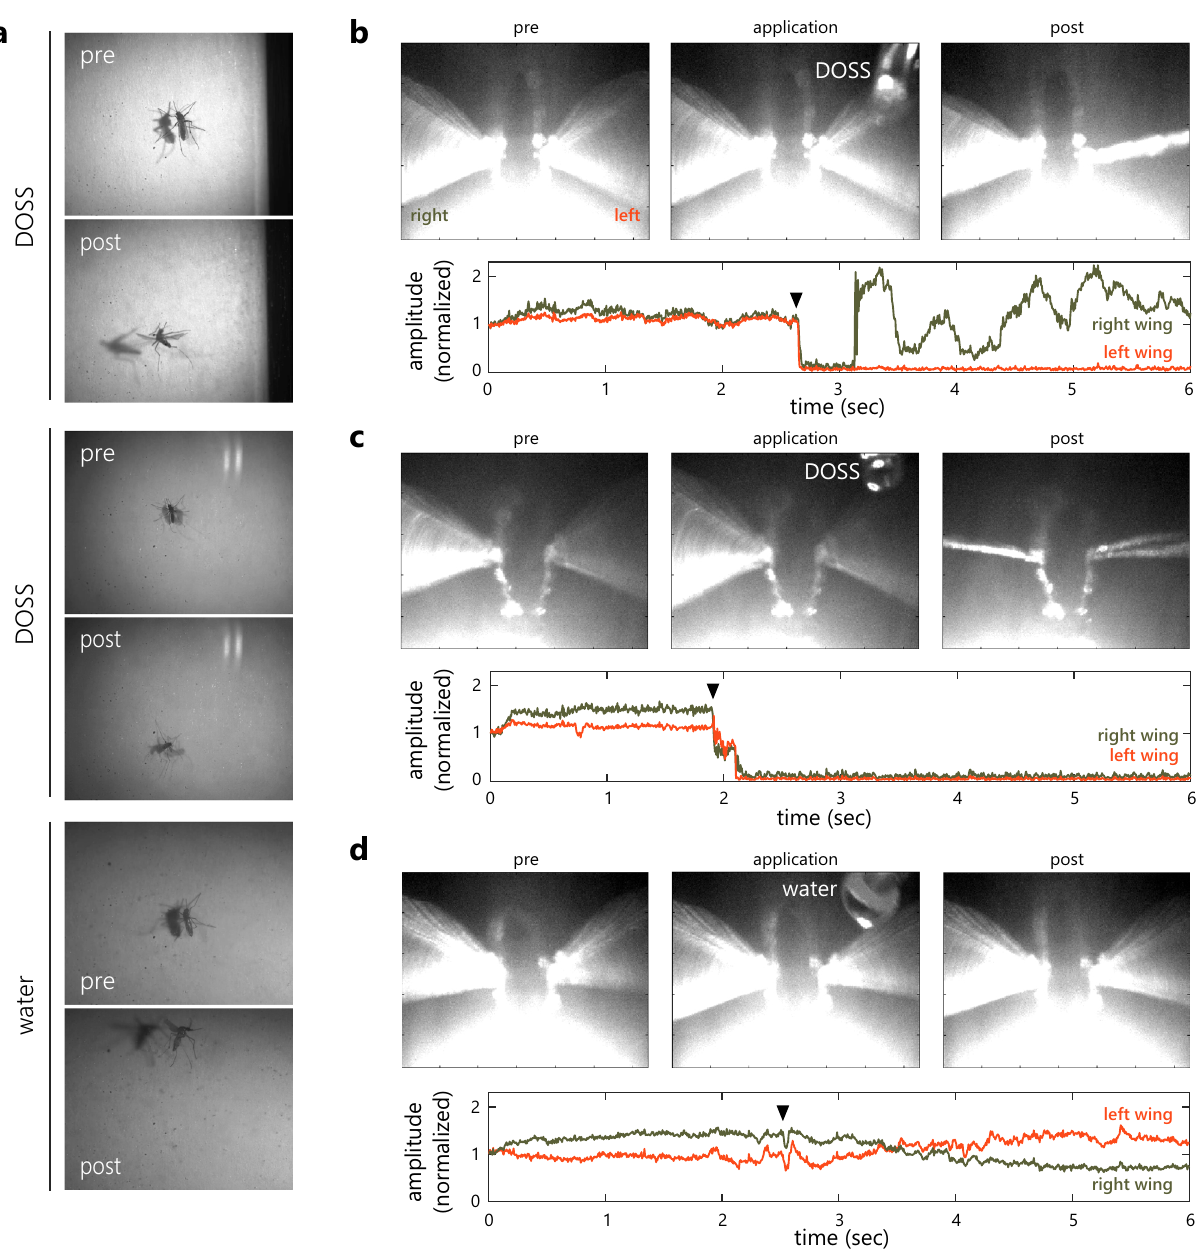
Figure 2. Surfactants affect mosquito flight. ( a ) Snapshots of movies taken with a high-speed camera capturing the behavior of mosquitoes on the wall after being sprayed with DOSS (top and middle) or water (bottom). Mosquitoes fall and fly upward in response to DOSS and water, respectively. ( b – d ) (Top) Mosquito flight behavior before (pre), during (application), and after (post) the application of 3 mM DOSS ( b , c ) or water ( d ) on the left wing. (Bottom) Wing beat amplitude of the left and the right wings recorded with microphones set in the immediate vicinity of the wing tips. Filled arrowhead indicates the timing of application of